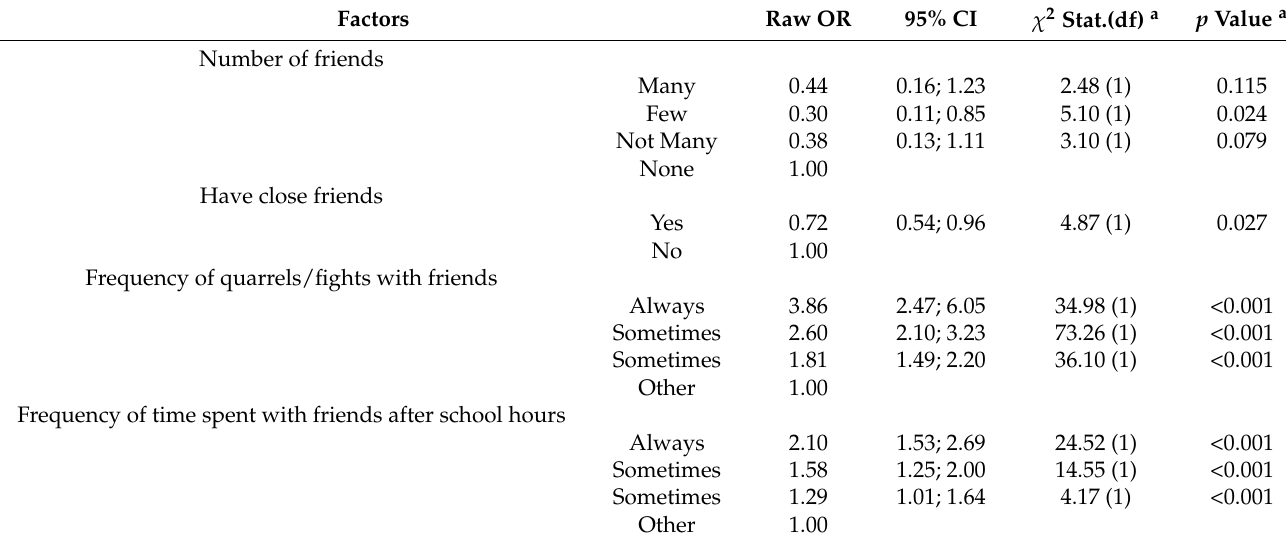
Table 6. Characteristics of peer factors related to bullying